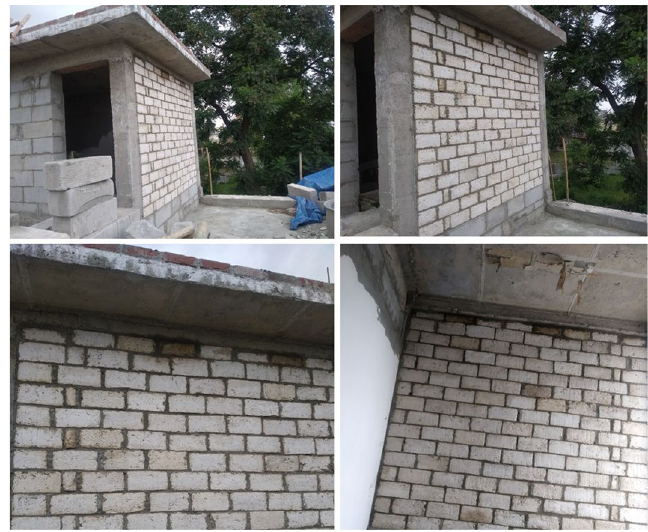
Figure 13. Prototype wall construction from gypsum-agro waste hollow blocks.